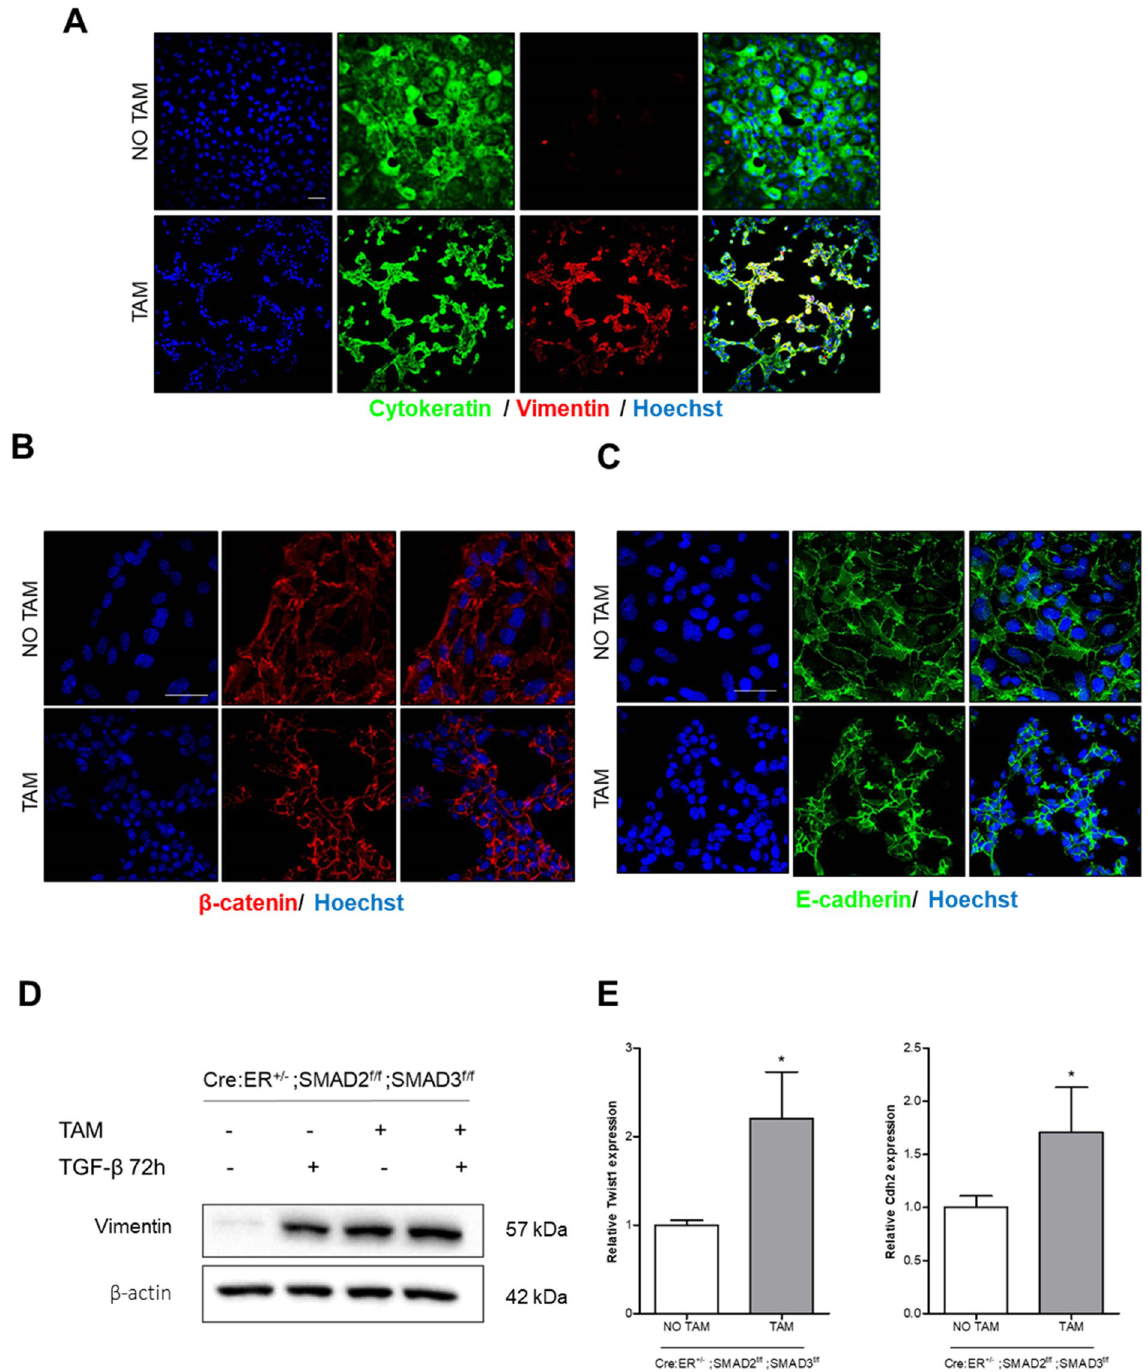
Figure 6. Representative confocal images of double cytokeratin and vimentin ( A ), β-catenin ( B ) or E-cadherin ( C ) immunofluorescence corresponding to 2D endometrial epithelial monolayers isolated from Cre:ER +/− ; SMAD2 f/f ; SMAD3 f/f , plated and treated with tamoxifen (TAM) to induce Cre:ER-mediated deletion of SMAD2 and SMAD3 alleles or left untreated (NO TAM). Images were captured after 3 days of tamoxifen-induced deletion. Cells were counterstained with Hoechst to visualize nuclei. Scale bars: 25 µm. D. Western blot analysis of vimentin expression on 2D endometrial epithelial monolayers isolated from Cre:ER +/− ; SMAD2 f/f ; SMAD3 f/f . Cells were treated (TAM) or not (NO TAM) with tamoxifen to induce Cre:ER-mediated deletion of SMAD2 and SMAD3 alleles and then stimulated or not with TGF-β for 72 h. Membranes were also blotted with β-actin antibody to ensure deletion of these proteins. E. RT-qPCR relative quantification of Cdh2 and Twist1 mRNA expression of 2D endometrial epithelial monolayers isolated from Cre:ER +/− ; SMAD2 f/f ; SMAD3 f/f . Cells were plated and treated (TAM) or not (NO TAM) with tamoxifen to induce Cre:ER-mediated deletion of SMAD2 and SMAD3 alleles. Values are mean and error bars represent mean ± S.E.M. * P < 0.001 by one-way